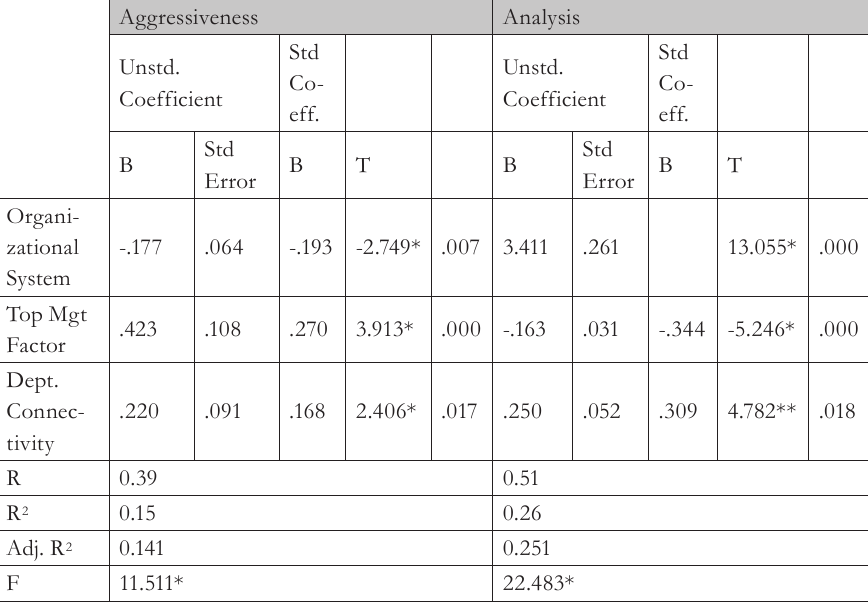
Tab. 4 - Impact of Organizational System, Top Management Factor, and Departmental Connec- tivity on Aggressiveness and Analysis Dimensions. Source: Field Survey.